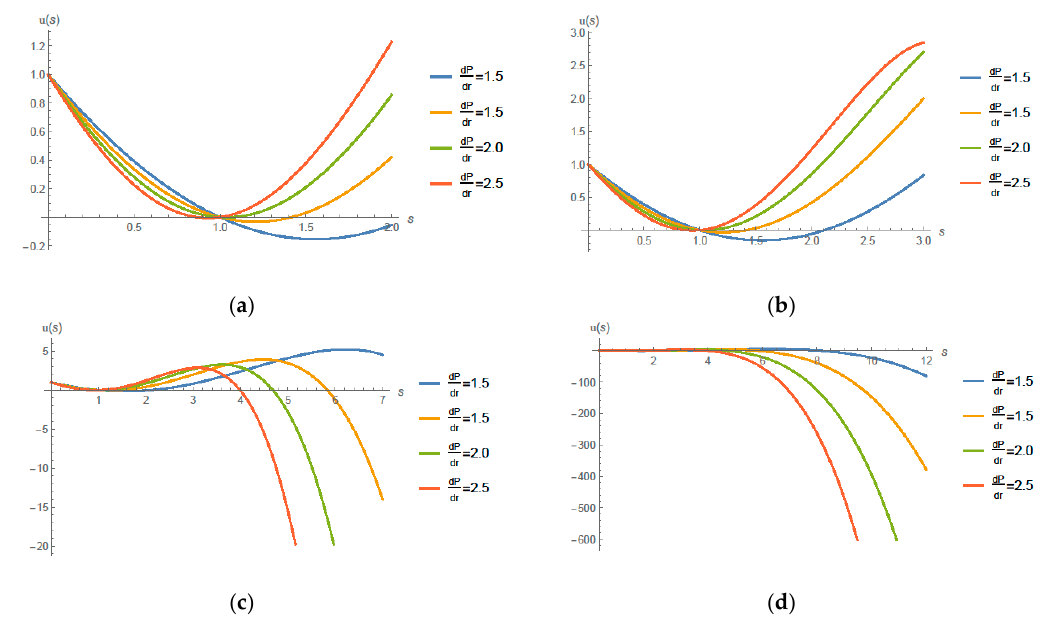
. (cid:2914)(cid:3045)